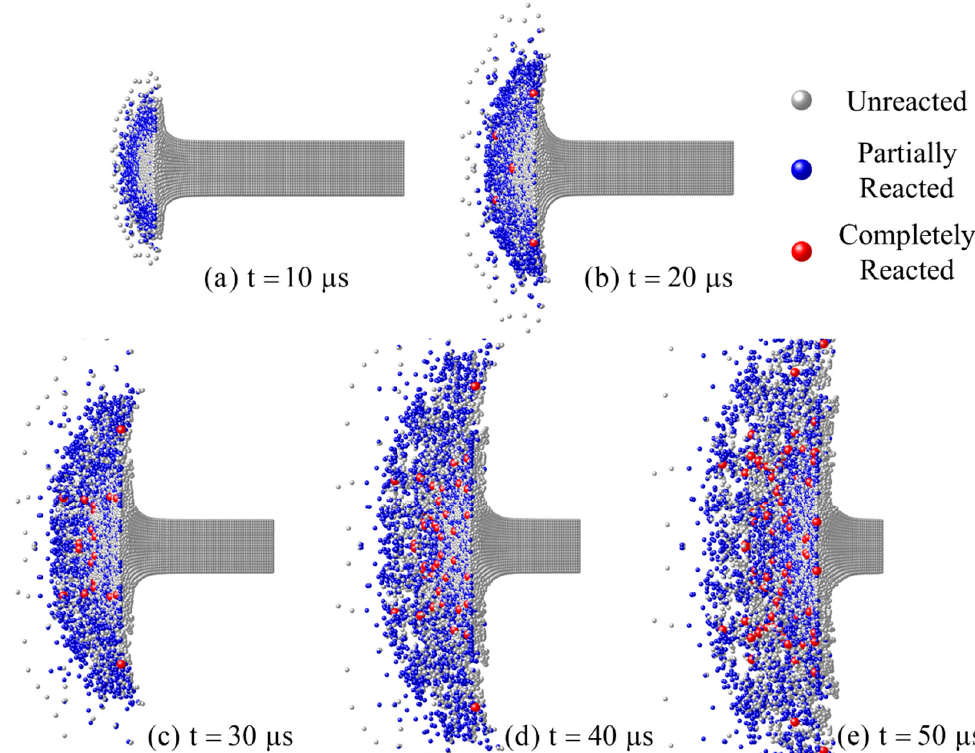
Figure 9. Reaction morphologies (cross-section view with a rotation angle of 30°) of RM rods with the impact velocity of 775 m/s at different times.